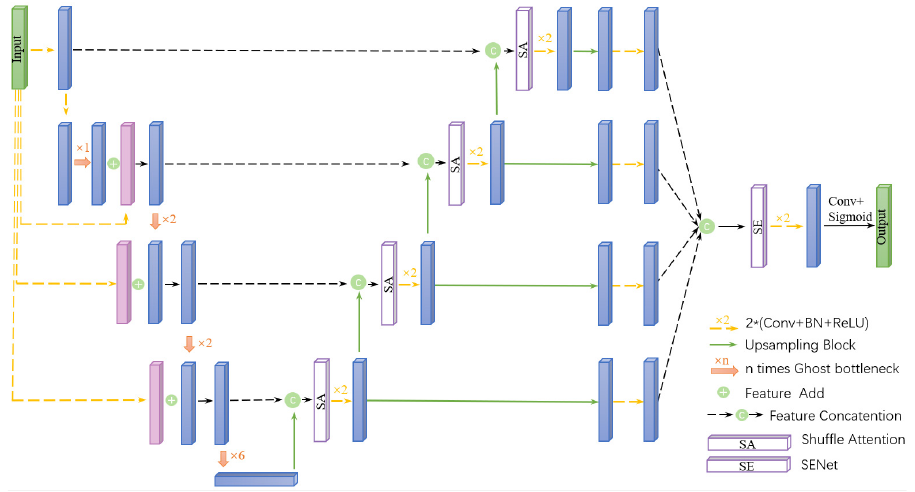
Figure 3. G-UNets network structure. Each blue or purple rectangle corresponds to a multi-channel feature map.